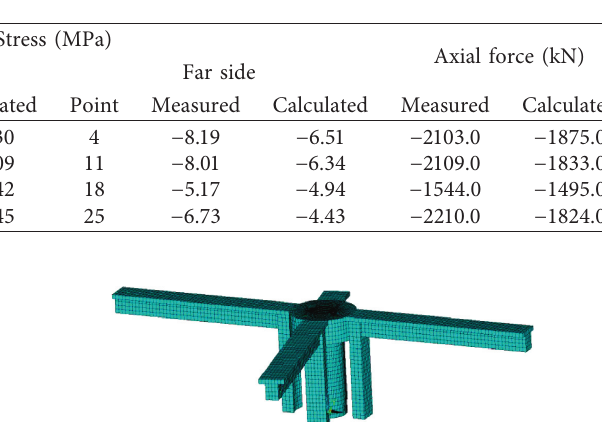
Table 1: Measured and calculated values of beam end displacement, stress, and axial force of the support columns at the end of the construction process.